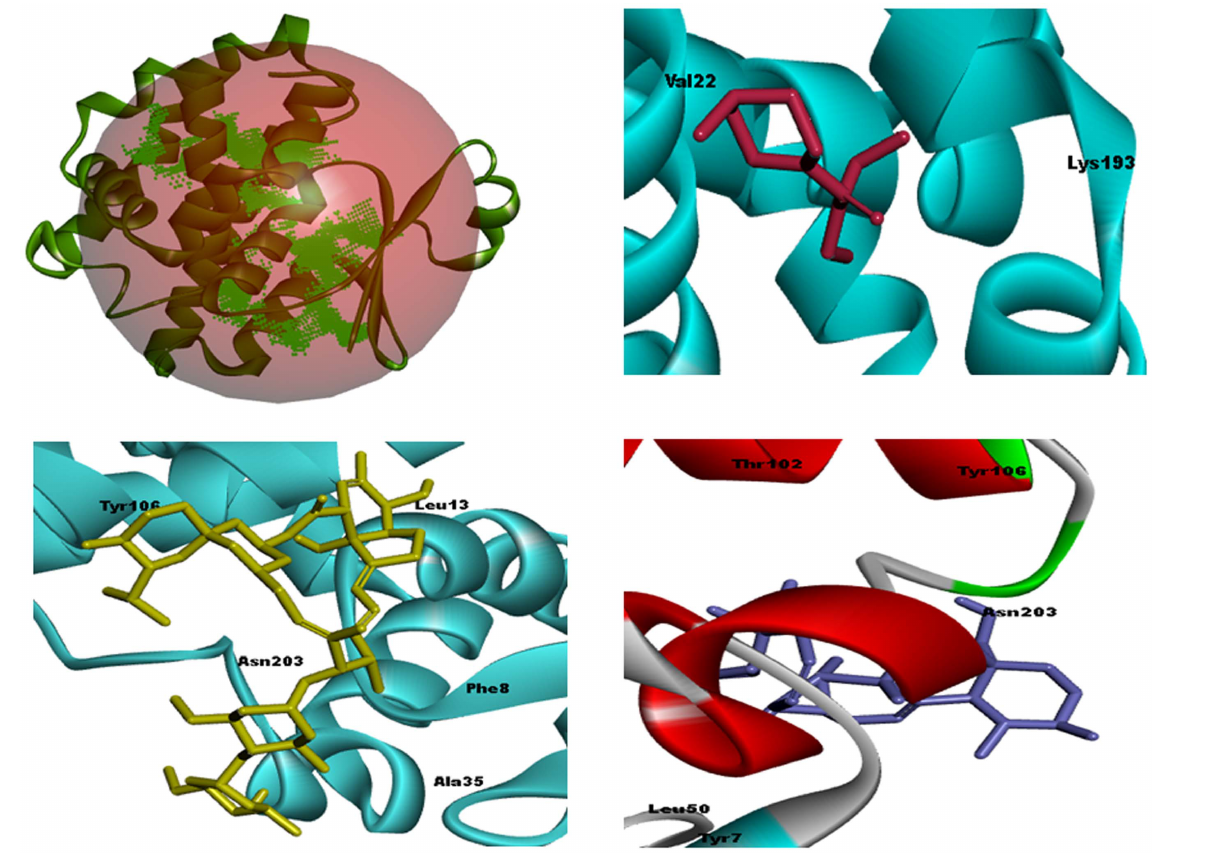
Figure 3. Docking results of studies compounds on B. malayi (Filarial nematode worm) glutathione-S-transferase ( Bm GST) homology model. (a) docked standard drug DEC-c (control) on BmGST model active site with docking energy 2 4.9 kcal mol 2 1 , (b) docked another standard drug Ivermectin (control) with docking energy 2 8.4 kcal mol 2 1 , (c) docked UA on BmGST model with high docking energy 2 8.6 kcal mol 2 1 .